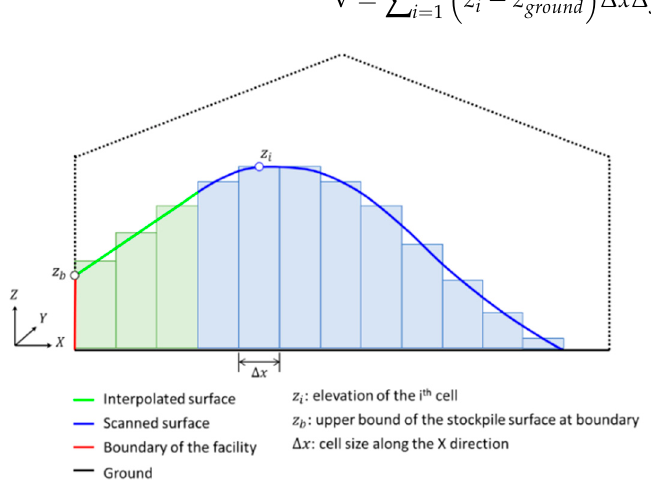
Figure 20. Schematic illustration of stockpile surface generation and volume estimation.